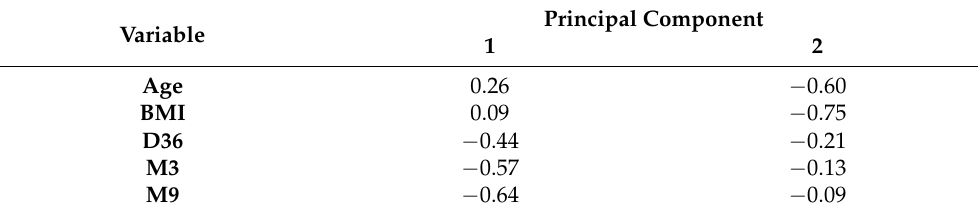
Table 2. Loadings for the two main principal components of the final PCA